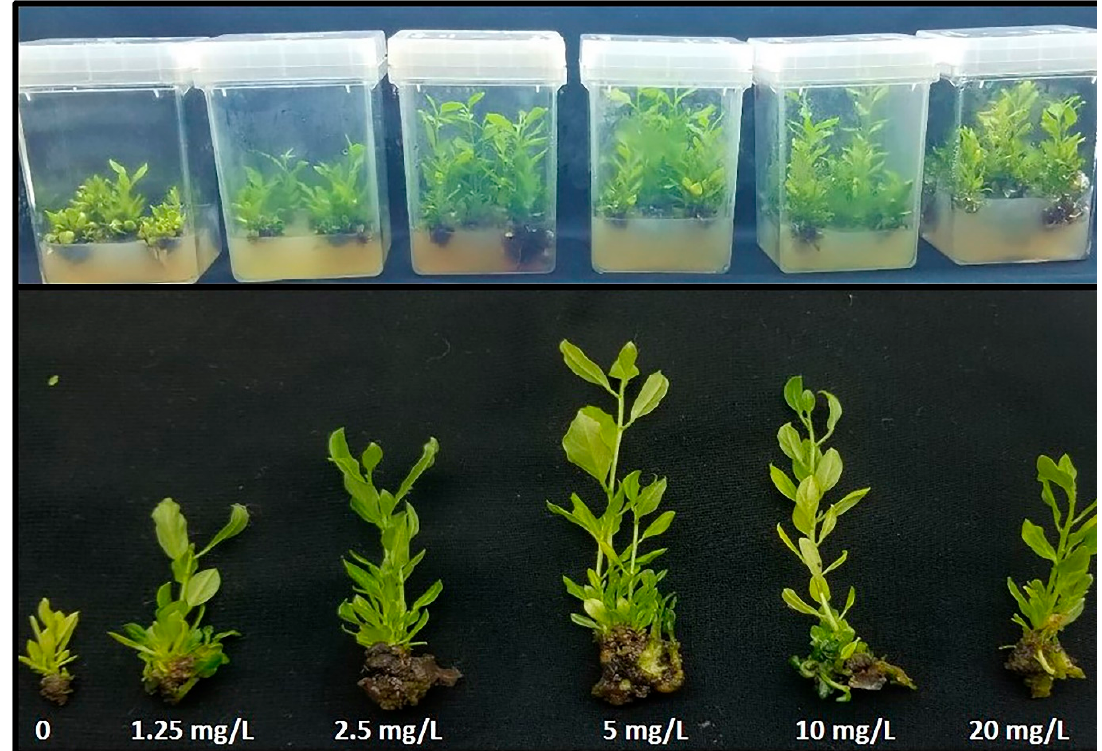
Figure 2. Effect of different concentrations of zinc oxide nanoparticles on in vitro multiplication of Maerua oblongifoli.